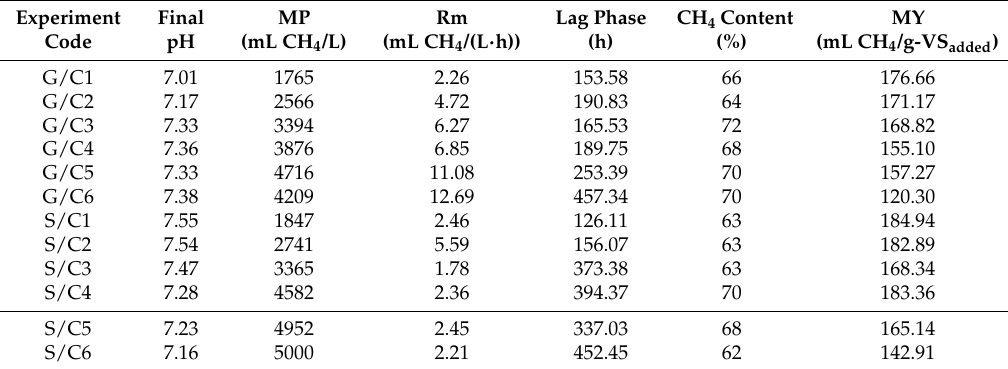
Table 2. MP, methane content, methane production rate (Rm) and methane yield (MY) by self-fermentation of a co-digestion of Napier grass with cow dung and silage with cow